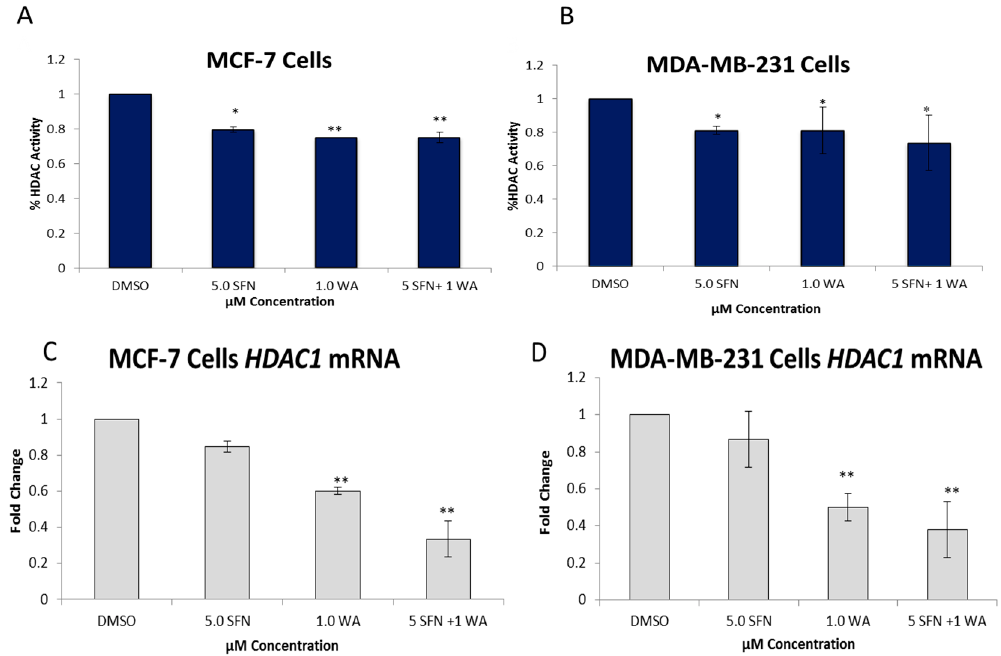
Figure 6. Combinatorial WA and SFN down-regulate histone deacetylase1 (HDAC) activity and mRNA expression. ( A ) HDAC activity/ inhibition assays were performed using nuclear extracts from 3-day treatments of MCF-7 cells at the indicated concentrations; ( B ) MDA-MB-231 cell HDAC activity assays were performed using the same methodology described above; ( C ) qRT-PCR was completed to determine the mRNA expression of HDAC1 in MCF-7 cells; ( D ) HDAC1 mRNA expression is shown in MDA-MB-231 cells. The results represent the means of three separately cultured experimental replicates. (* p < 0.05, ** p < 0.01)